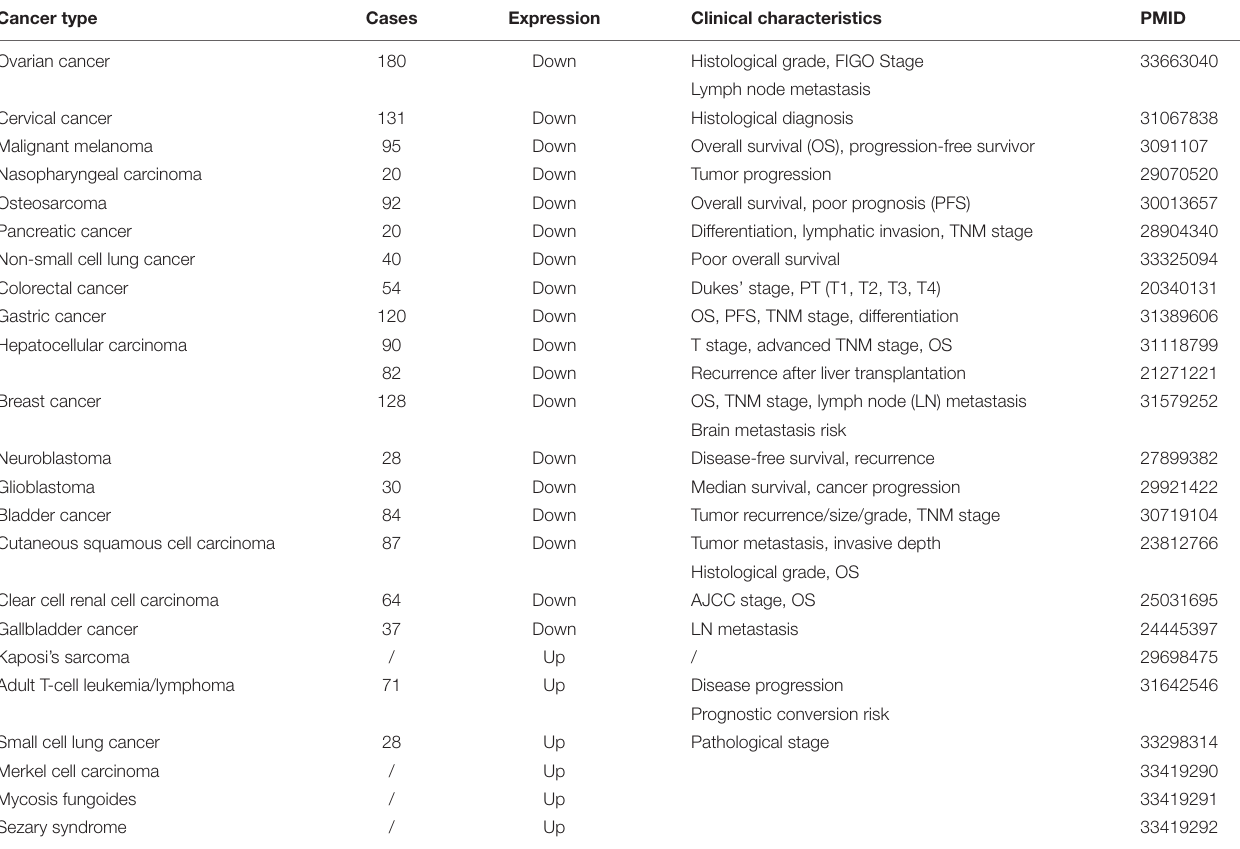
TABLE 1 | Summary of the clinical characteristics of CADM1 in malignant